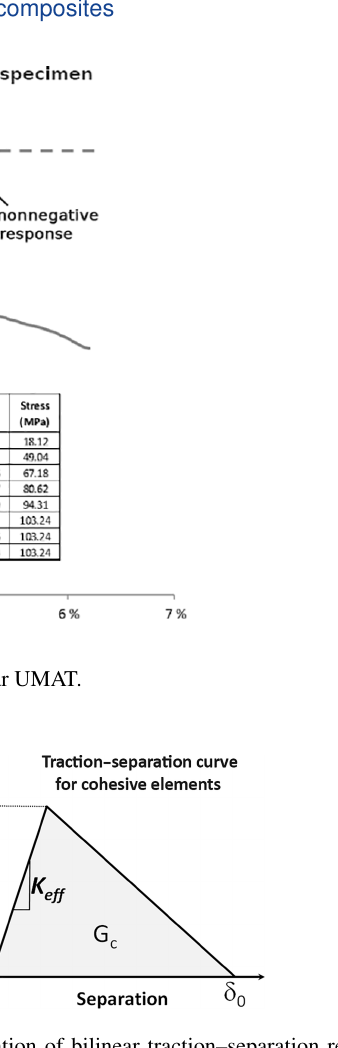
Figure 4. Representation of bilinear traction–separation response for a cohesive